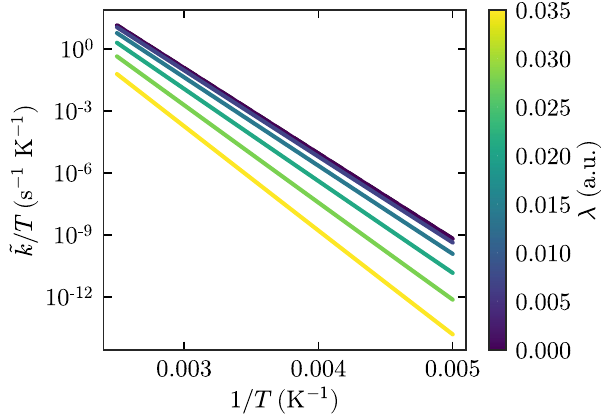
FIG. 2. Arrhenius plot for the rate dependence with the temperature in the hybrid system for several light-matter coupling values. See the main text for